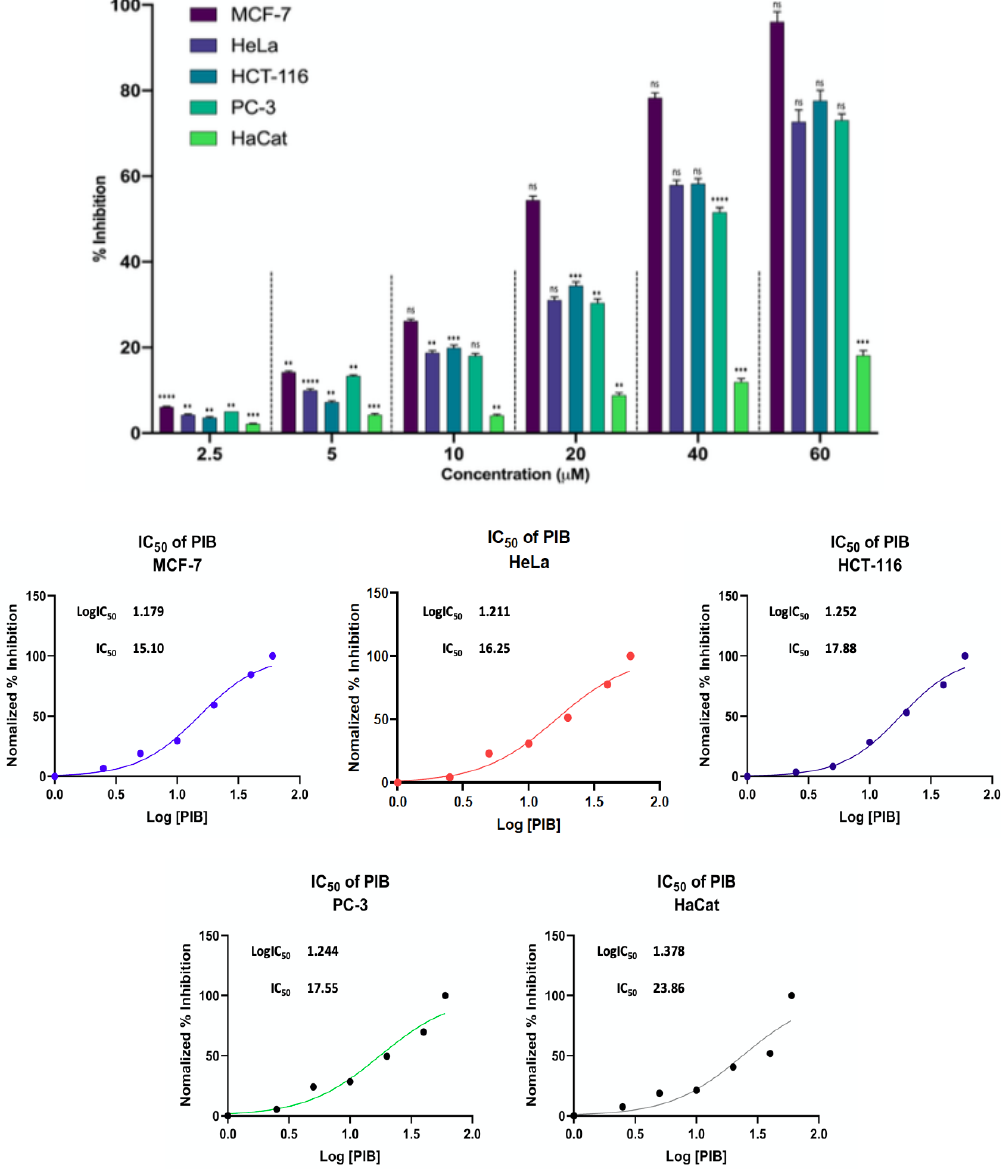
Figure 1. PIB showed highest cytotoxicity in breast and colorectal cancer cell lines. Upon treatment of PIB for 24 h on breast (MCF-7), cervical (HeLa), colorectal (HCT-116) and prostate (PC-3) cell lines, % inhibition of ~97% of MCF-7 and ~80% of HCT-116 cells was observed, while ~75% of HeLa and PC-3 was recorded. The anti-cancer activity observed in all the cell lines as dose-dependent. PIB showed ~20% growth inhibition in normal human keratinocyte, HaCat, cell line. In addition, the number of cells were much lesser in the PIB treated groups. n = 3, mean ± SEM, p value of <0.05 was considered to be significant, ** p ≤ 0.01, *** p ≤ 0.0001, **** p ≤ 0.00001 and ns = not significant. The IC 50 values of PIB on MCF-7, HeLa, HCT-116, PC-3 and HaCat were observed to be 15.10, 16.25, 17.88, 17.55 and 23.86 micromoles, respectively.